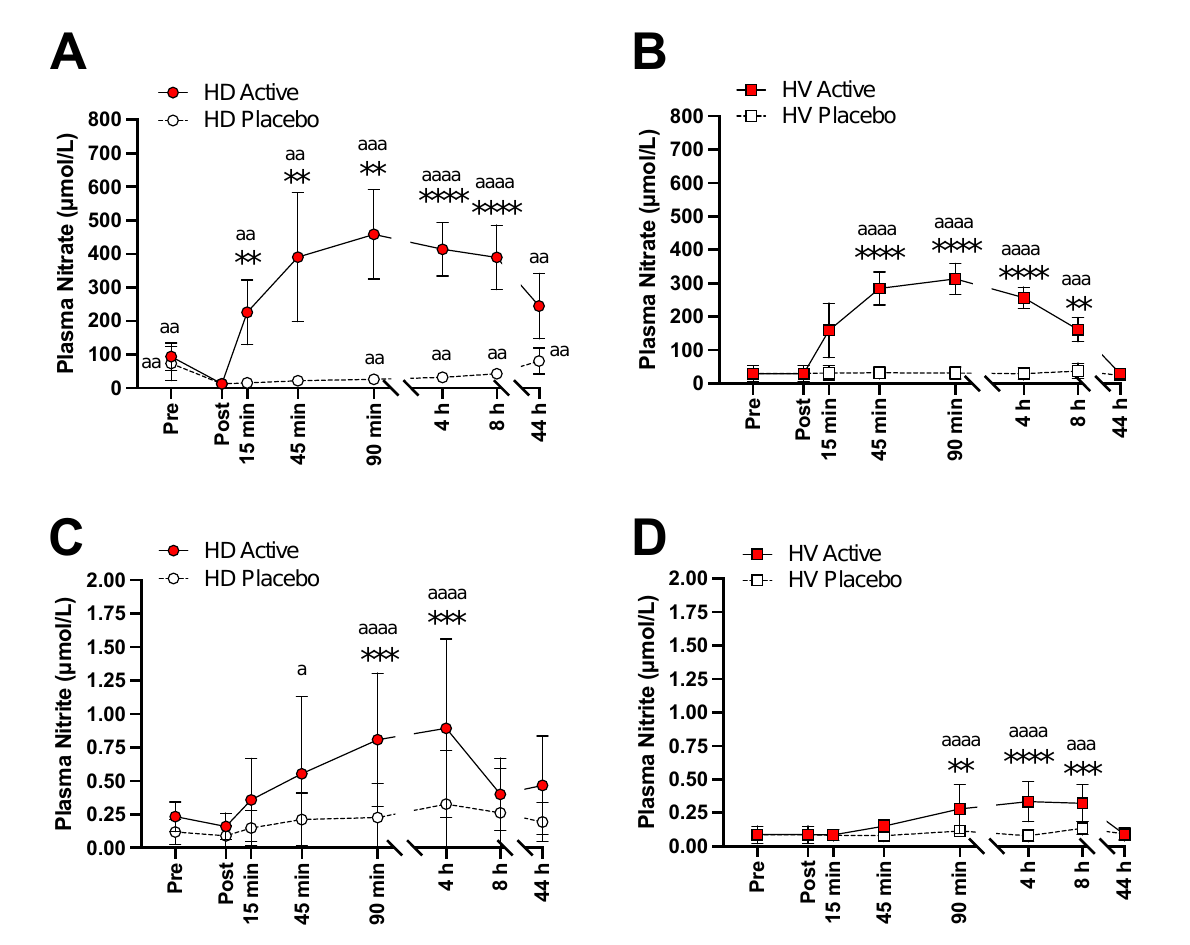
Figure 1. Plasma levels of nitrate and nitrite after single ingestion of nitrate-enriched (Active) and nitrate-depleted (Placebo) beetroot juice (BJ) in hemodialysis patients and in healthy volunteers. Legend: Plasma nitrate ( A , B ) and nitrite ( C , D ) levels in hemodialysis patients (HD, left panels) and in healthy volunteers (HV, right panels) after active BJ (filled red) or placebo BJ (open white) ingestion, respectively. HD, hemodialysis patients; HV, healthy volunteers. Values are presented as mean and standard deviation. ** p < 0.01; *** p < 0.001; **** p < 0.0001 as compared with placebo in the same group. a p < 0.05; aa p < 0.01; aaa p < 0.001; aaaa p < 0.0001 as compared with “post” values in HD patients or “baseline” values in HV, before active BJ and placebo BJ ingestion, respectively.